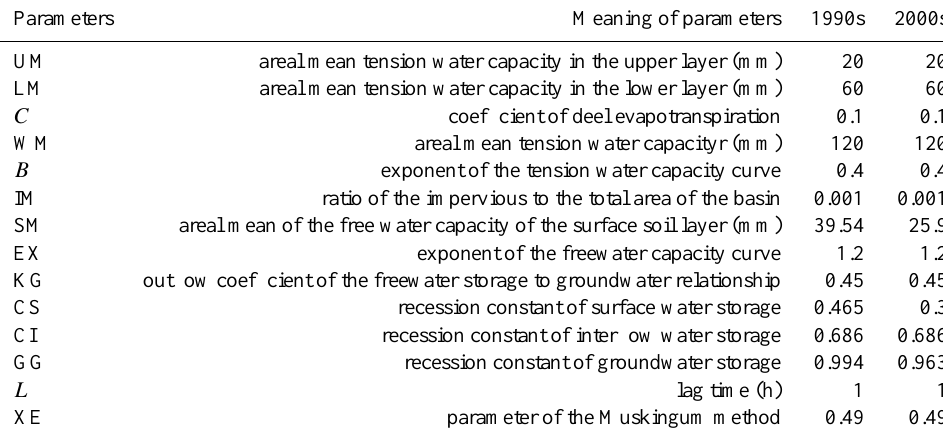
Table 1. Calibrated parameters for the daily Xinanjiang model in Dapoling sub-basin. Parameters